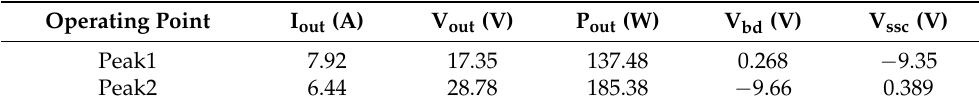
Table 5. Terminal voltage of the shadowed solar cell and relevant bypass diode at different working points.